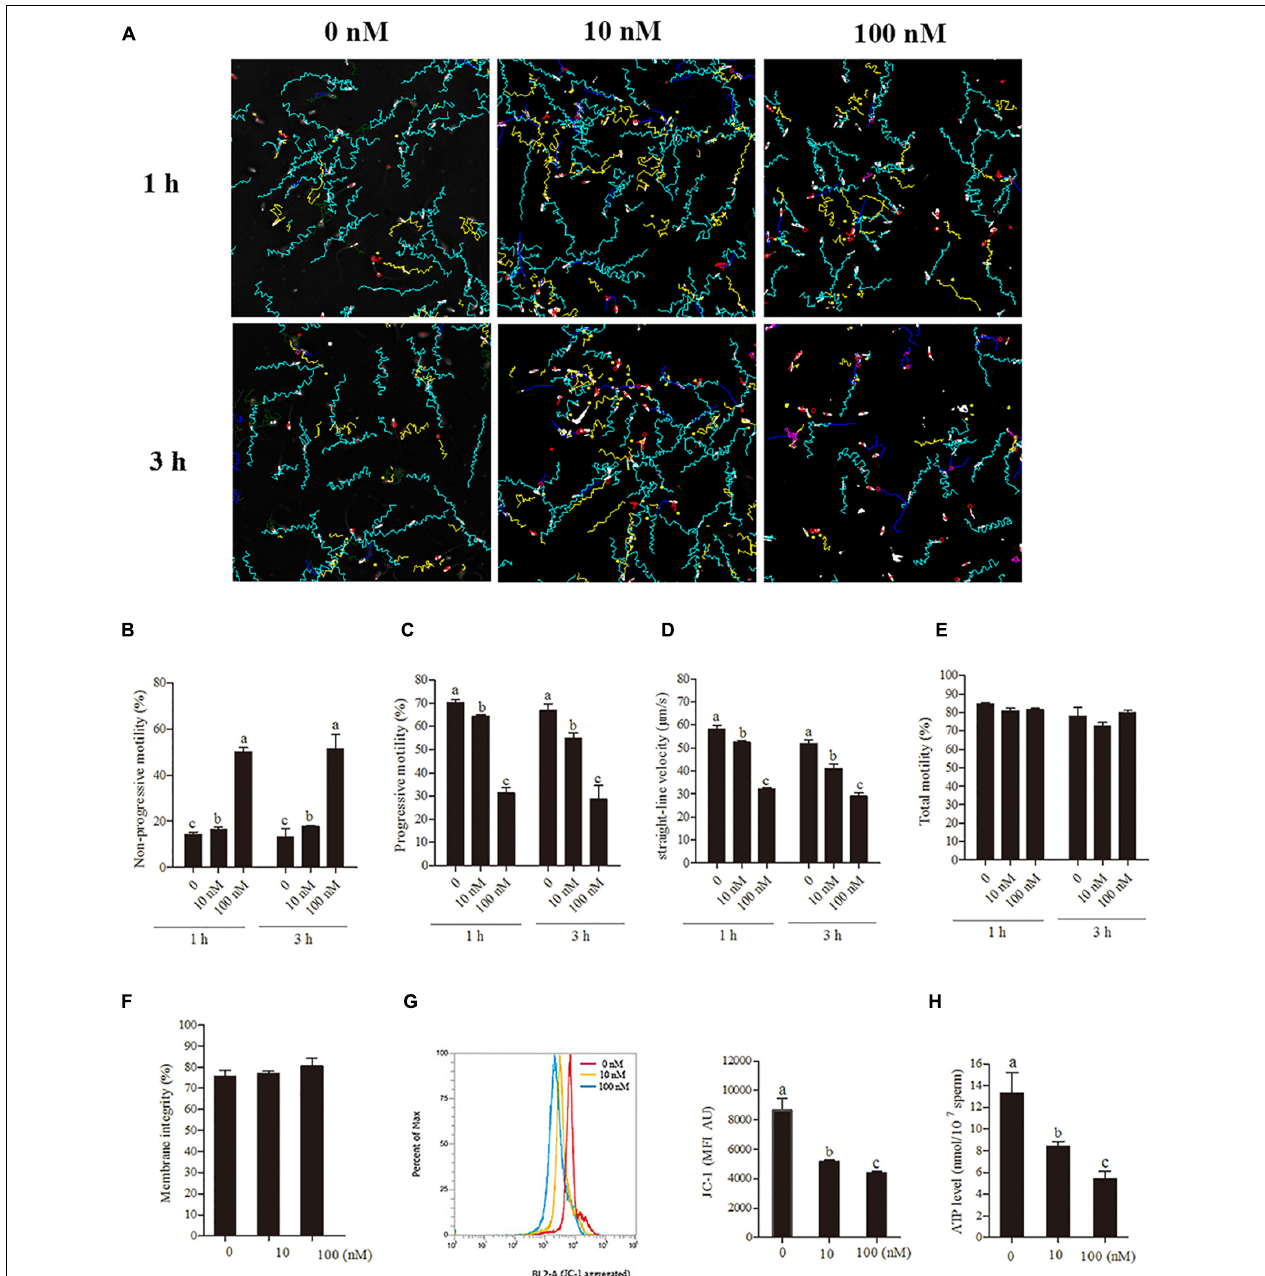
FIGURE 2 | Sperm incubated with rotenone in 30.6 mM glucose media alters the mitochondrial activity, ATP level and kinetic patterns. (A–E) Kinetic changes in the sperm motility patterns at 1 and 3 h of incubation, (A) motility tracks generated from CASA, (B) non-progressive motility, (C) progressive motility, (D)